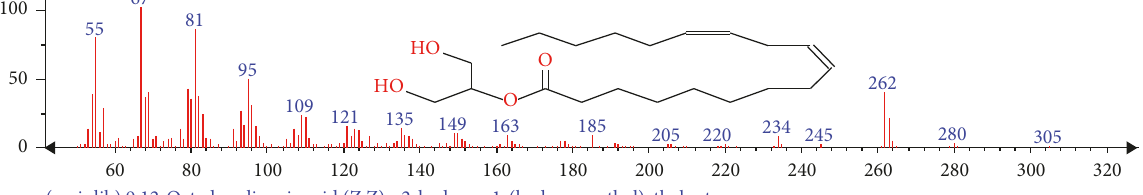
Figure 55: Mass spectrum of compound 9,12-octadecadienoic acid (Z,Z)-, 2-hydroxy-1-(hydroxymethyl)ethyl ester of whole plant hexane fraction of Achillea wilhelmsii (WHFAW).